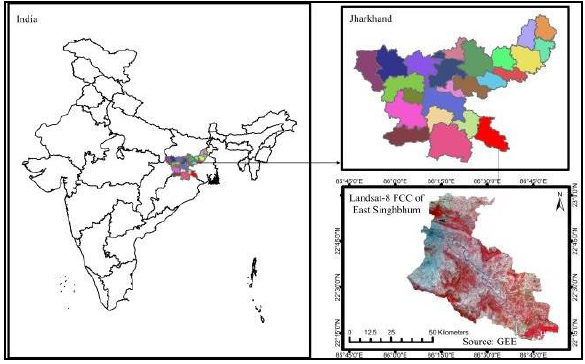
Figure 1 . Location map of the study site